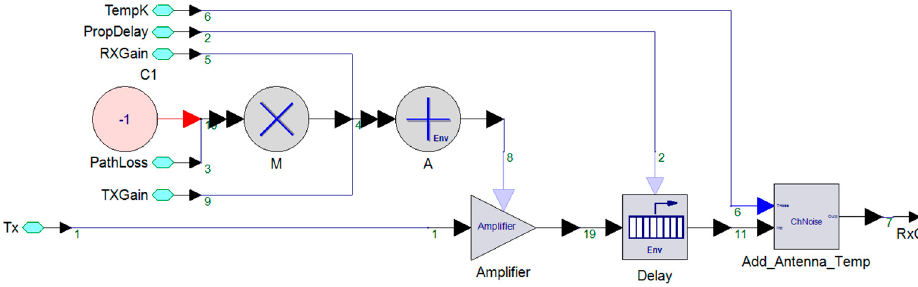
Figure A4. Details inside App_STK_Data model in Figure A3 to apply STK data onto the complex envelope TX (cid:3398) signal in Figure A3.